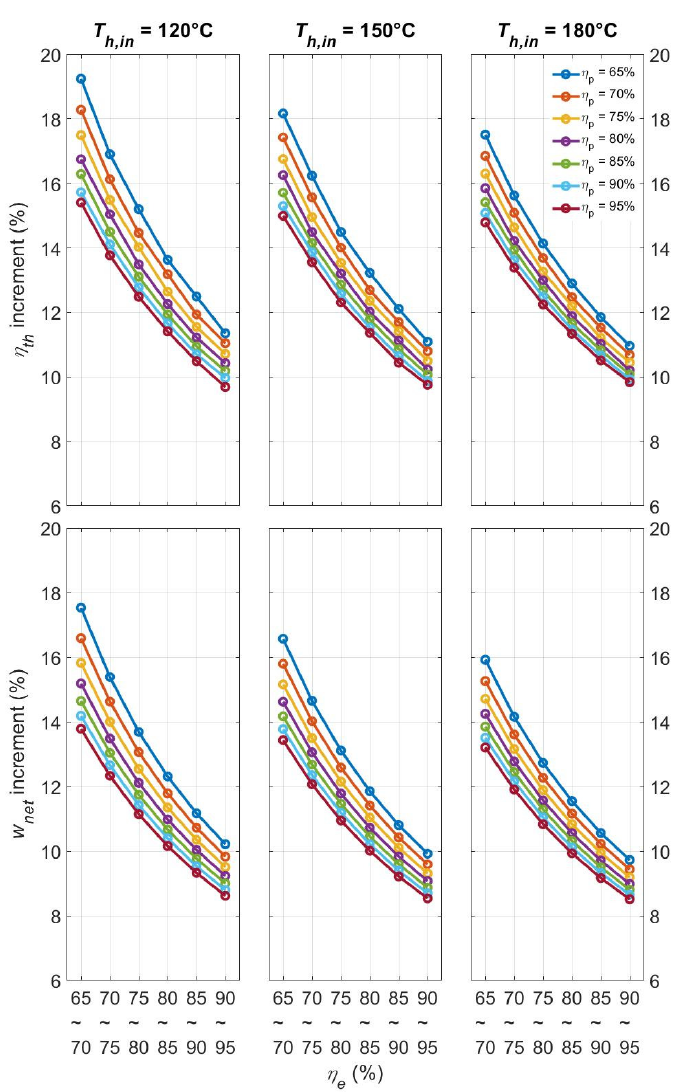
Figure 7. η th and w net increments of the simple cycle at the design point resulting from enhancing η e Figure 7. 𝜂 (cid:3047)(cid:3035) and 𝑤 (cid:3041)(cid:3032)(cid:3047) increments of the simple cycle at the design point resulting from enhancing 𝜂 (cid:3032) .